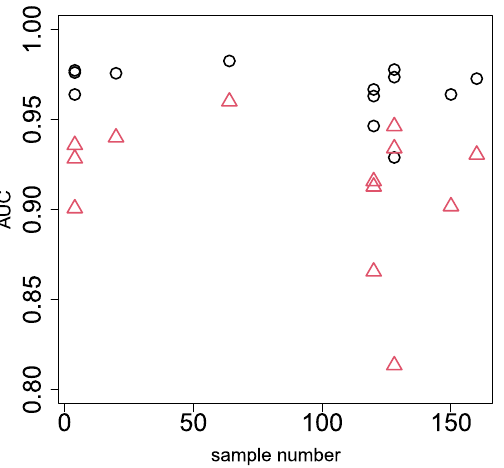
Figure 9. Coincidence of top-ranked genes between DESEq2 and PCA-based unsupervised FE using the SEQC data set. Open circles: AUC when P values computed by PCA-based unsupervised FE with optimized SD discriminates top 1000 genes ranked by P values computed by DESeq2. Open red triangles: AUC when P values computed by DESeq2 discriminating top 1000 genes ranked by P values computed by PCA-based unsupervised FE with optimized SD.